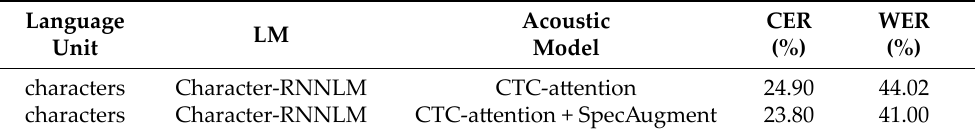
Table 2. Character‑based end‑to‑end model results with character recurrent neural network lan‑ guage modeling